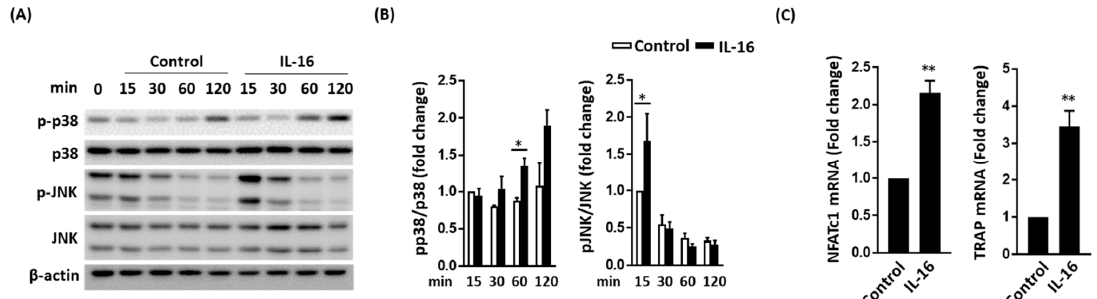
Figure 2. Interleukin (IL)-16 contributed to osteoclast activation through p38 and JNK MAPK signaling. ( A , B ) IL-16 accelerated the activation of p38 and JNK MAPK signaling; ( C ) IL-16 enhanced mRNA expression of TRAP and NFATc1. Data are presented as means ± standard errors of the mean. Analyses were conducted using a two-way analysis of variance followed by Bonferroni’s post hoc test. * p < 0.05 and ** p < 0.01. Abbreviations: IL, interleukin; pp38, phospho-p38; JNK, c-Jun N-terminal kinase; TRAP, tartrate-resistant acid phosphatase; NFATc1, nuclear factor of activated T cells 1.